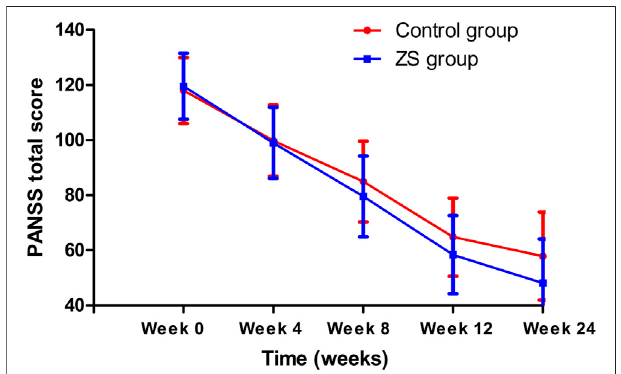
FIGURE 2 | The trajectory of the PANSS total scores in each treatment group.